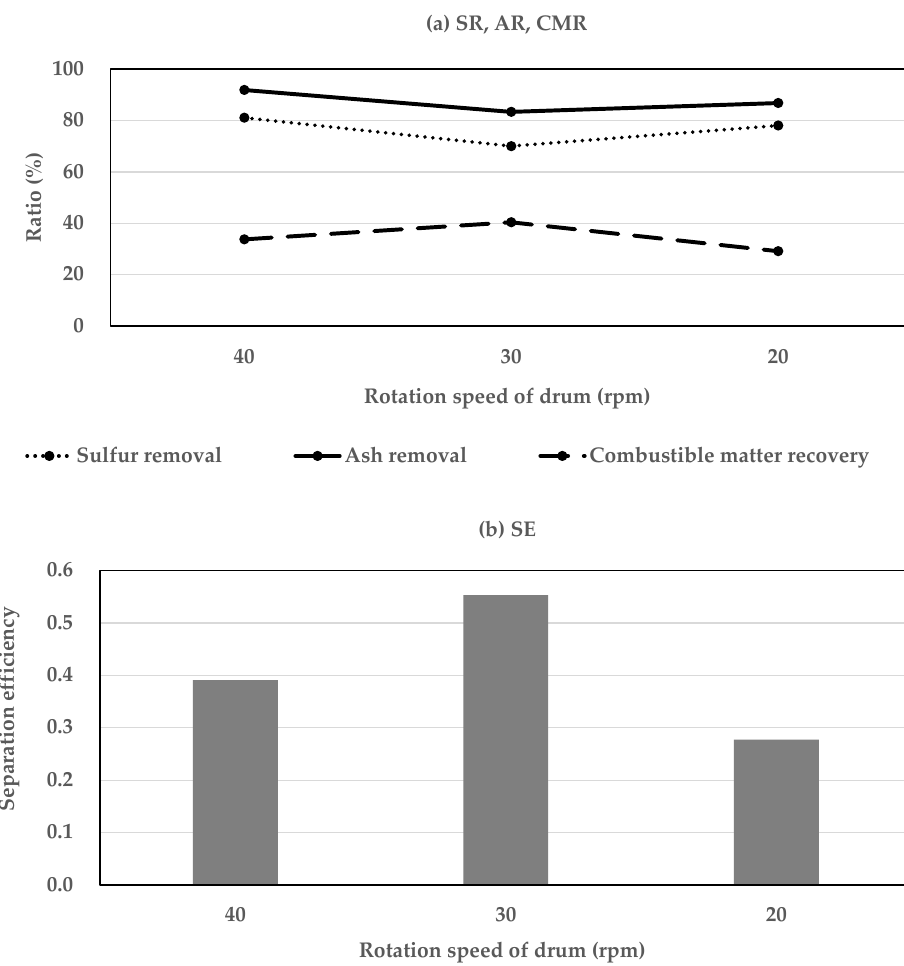
Figure 6. Performance of the separator at different drum rotational speeds: ( a ) ash removal ratios (%), sulfur removal ratios (%), and combustible matter recovery ratios (%); ( b ) efficiency of coal separation using a dry coal cleaning system with two-stage corona electrostatic processes.